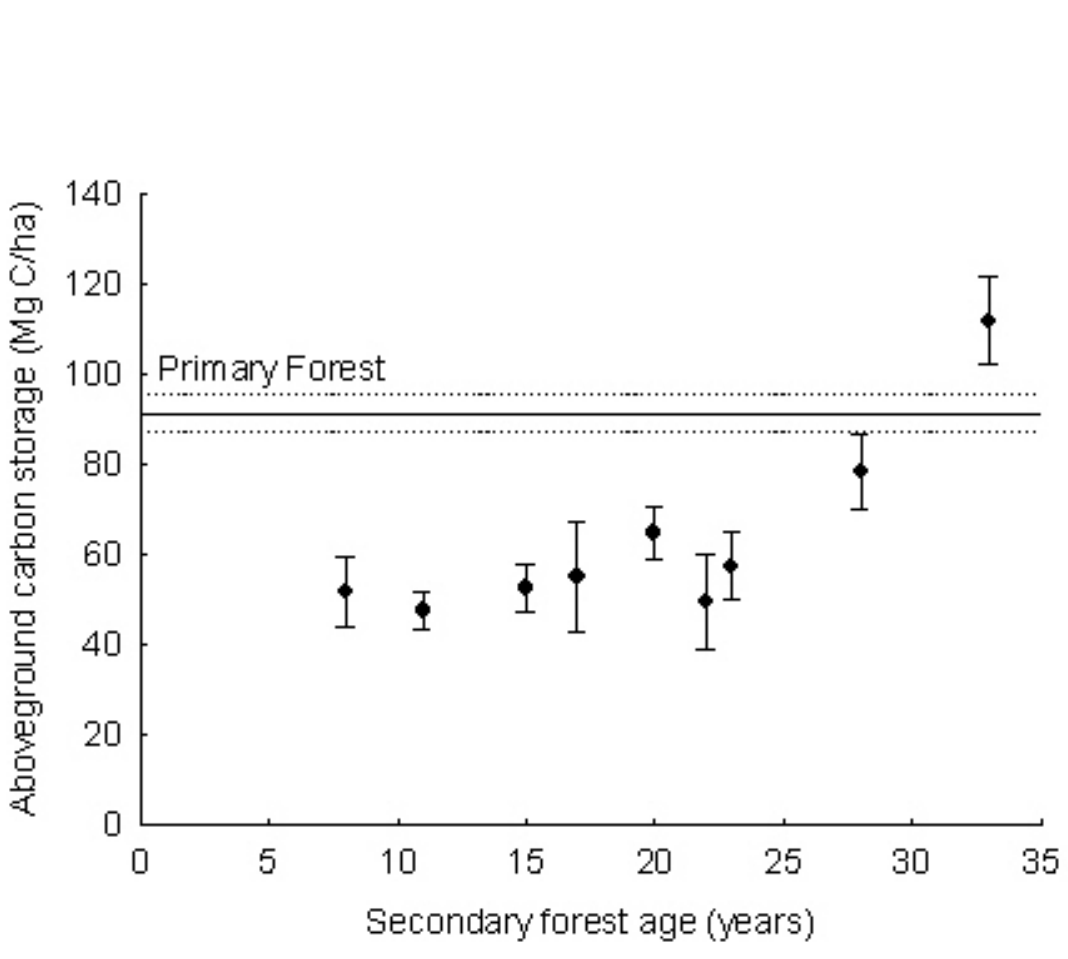
Fig. 4 . Mean aboveground carbon storage ± one standard error for each secondary-forest site. The solid and dotted horizontal lines represent mean aboveground carbon storage and one standard error, respectively, as measured in undisturbed primary forests at the La Selva Biological Station (Clark and Clark